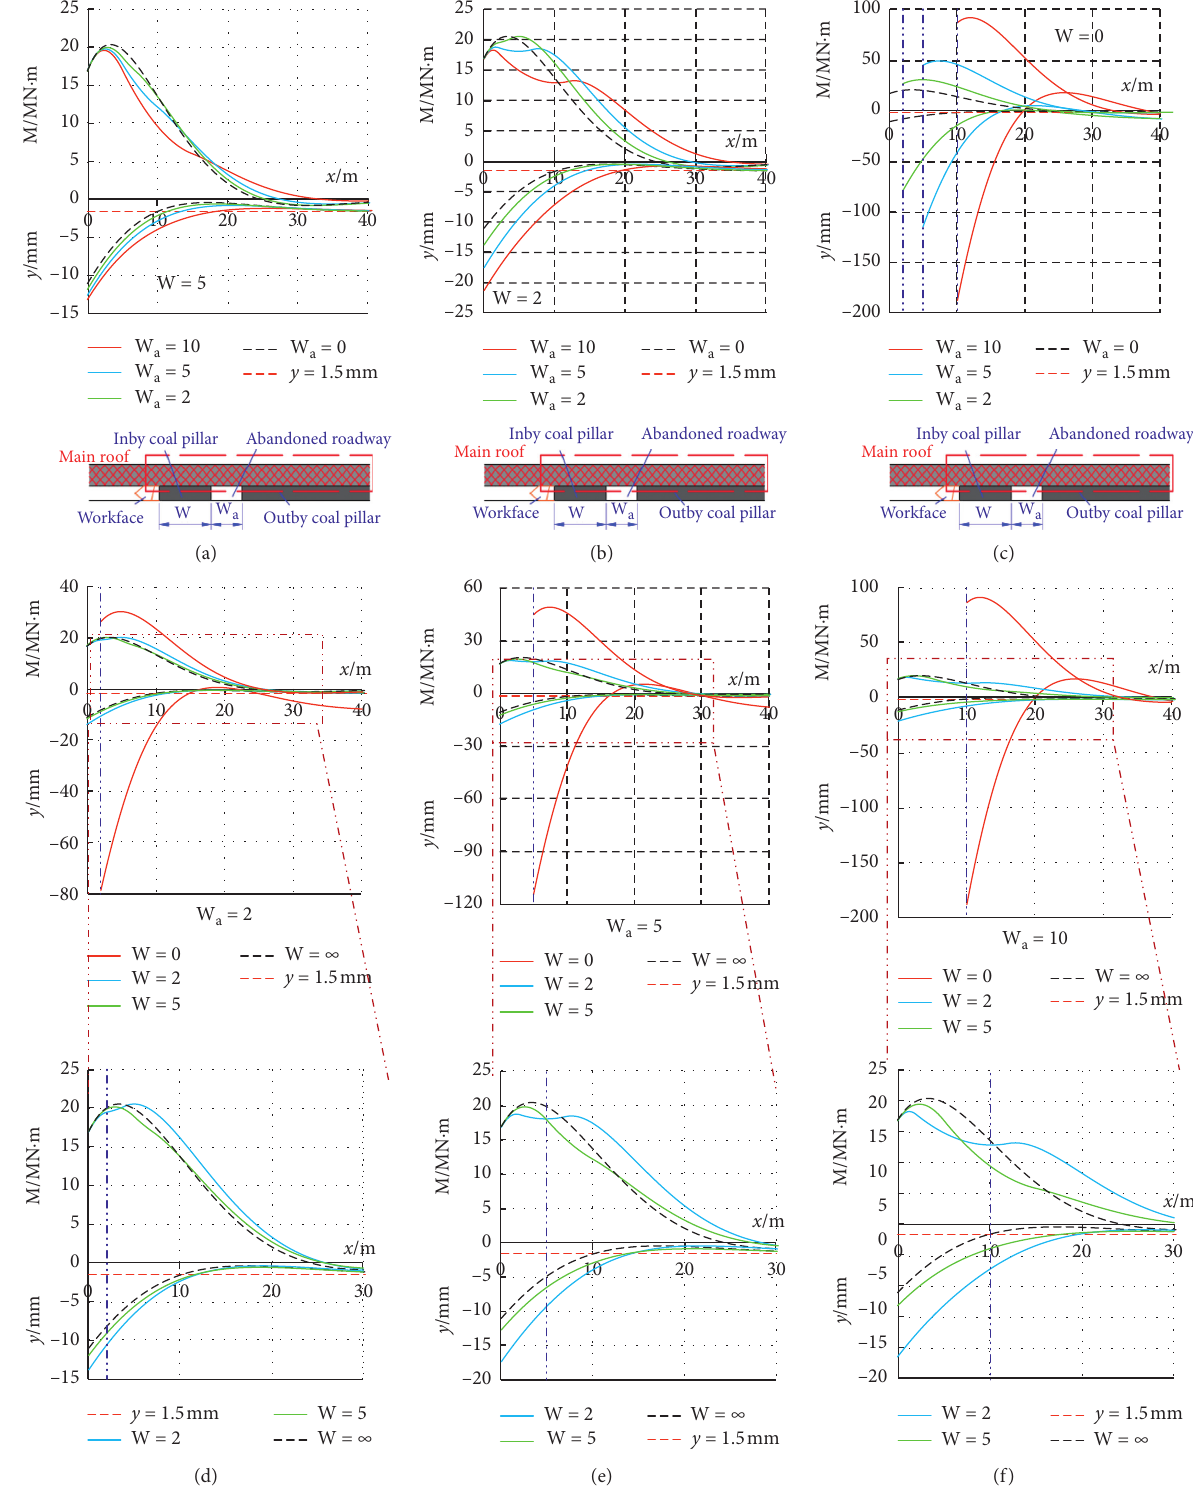
Figure 8: Evolution laws of bending moment and vertical deflection in the main roof. (a) Bending moment ( W � 5m), (b) bending moment ( W � 2 m), (c) bending moment ( W � 0m), (d) vertical deflection ( W a � 2 m), (e) vertical deflection ( W a � 5m), and (f) vertical deflection ( W a �